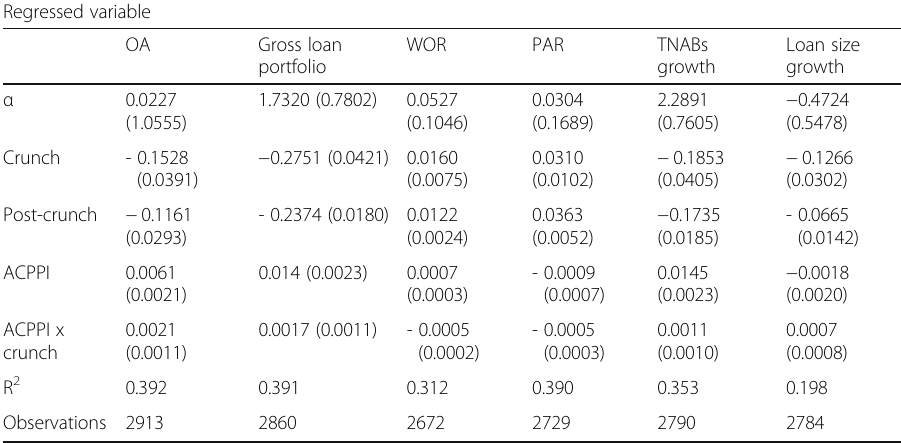
The table represents the output of fixed effect method applied for analyzing the performance of MFIs as in eq. 1 by using the crunch and post crunch dummies in addition to the alpha value, R 2 and total observations of all performance regression is shown. The values of standard errors are presented in